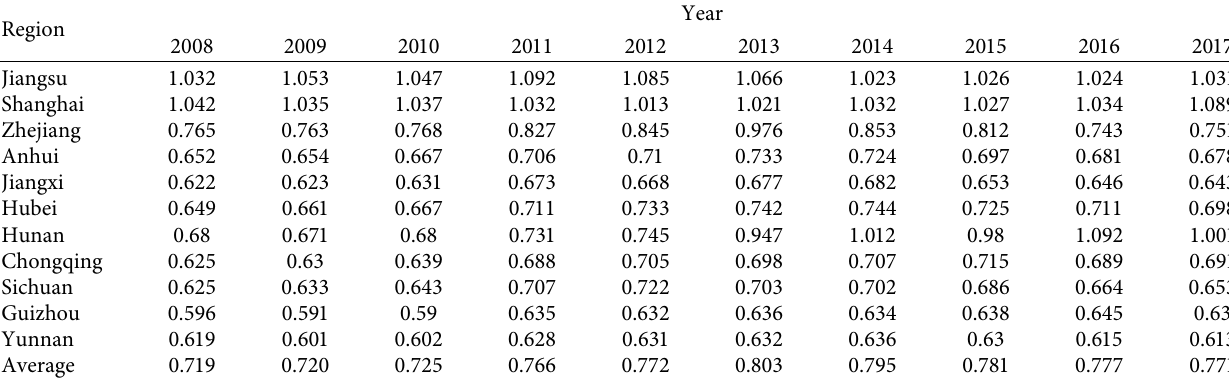
Table 4: Green innovation efficiency of YREB in 2008–2017.